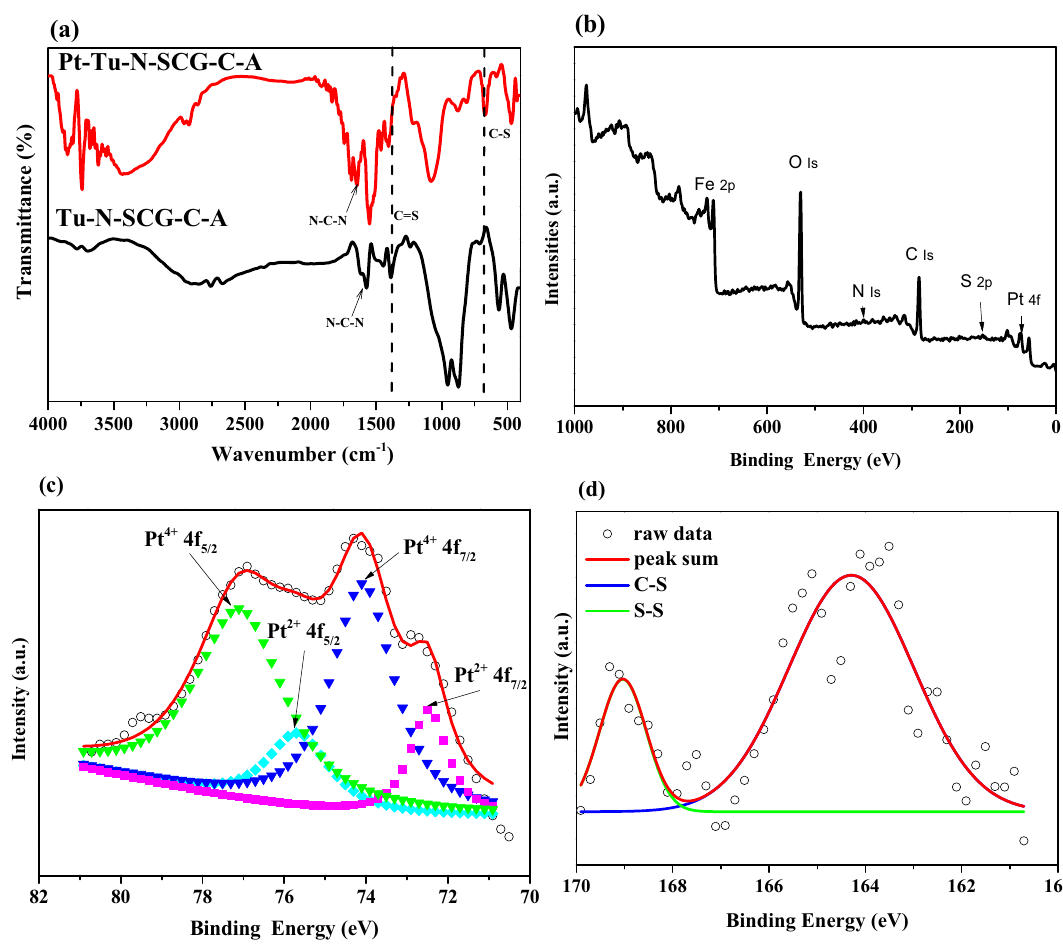
Figure 9. ( a ) FTIR spectra of Tu–N–SCG–C–A and Pt–Tu–N–SCG–C–A, ( b ) XPS survey, ( c ) Pt 4f. and ( d ) S 2 p spectra of